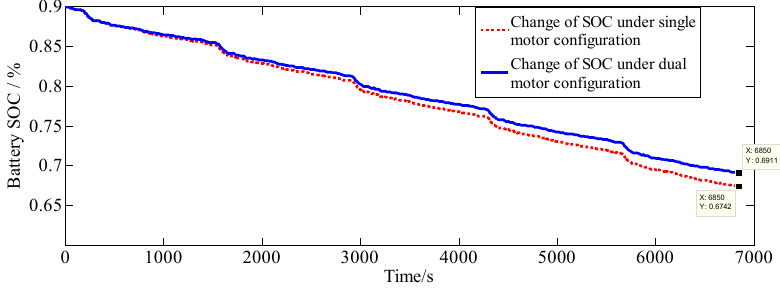
Figure 9. Battery SOC curve under two configurations.